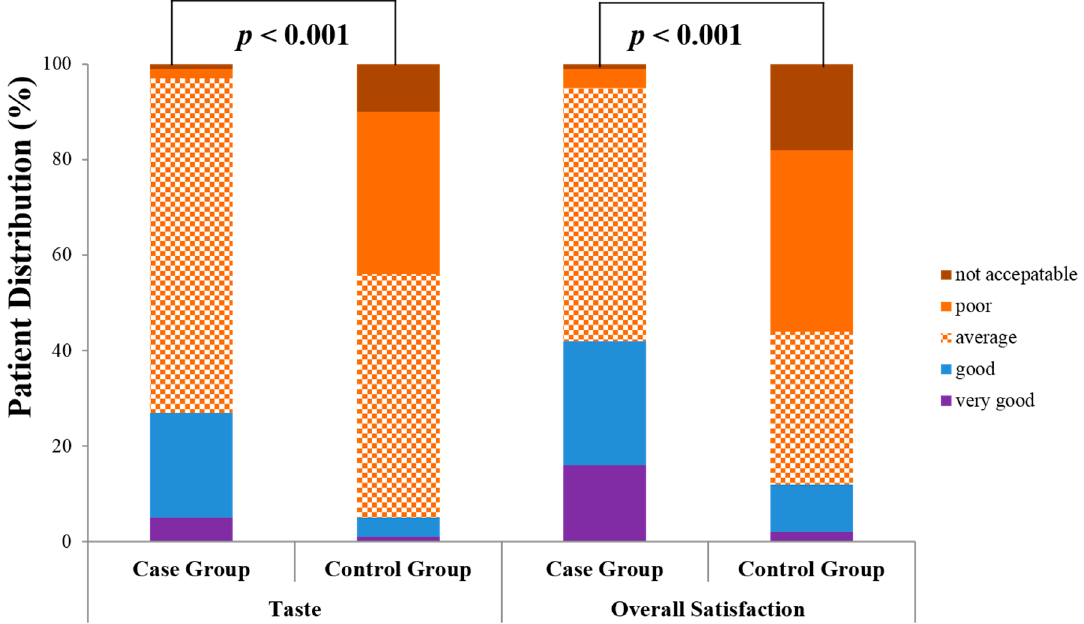
Figure 2. Patient tolerability profiles for bowel preparation agents.